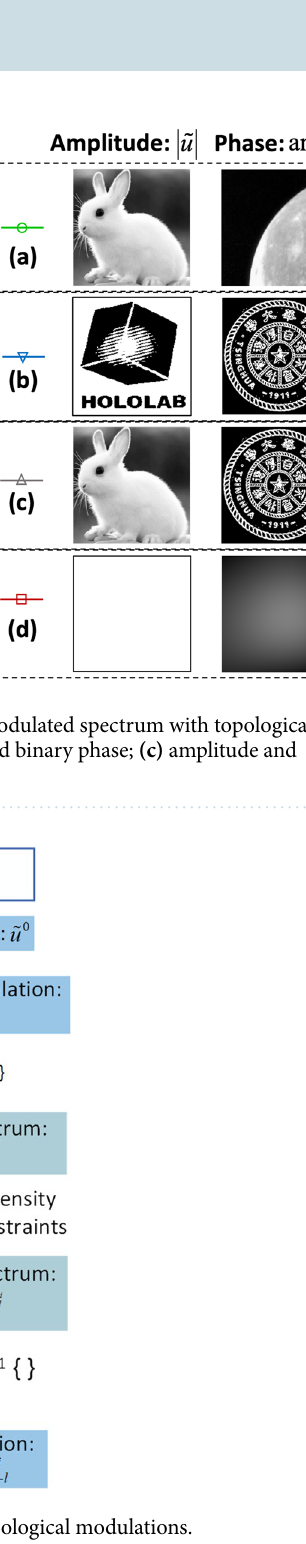
Figure 5. Flowchart of the reconstruction iteration algorithm using topological